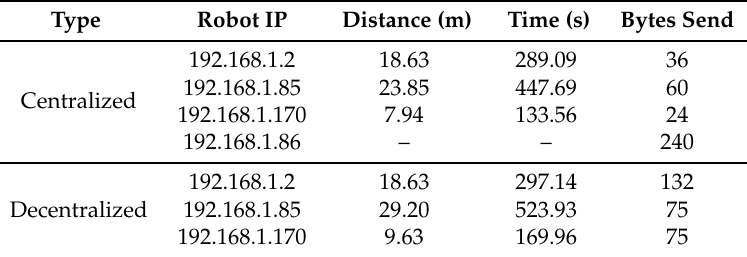
Figure 10. Topological map processed by three robotic agents. Table 7. Results from the experiment with three robotic